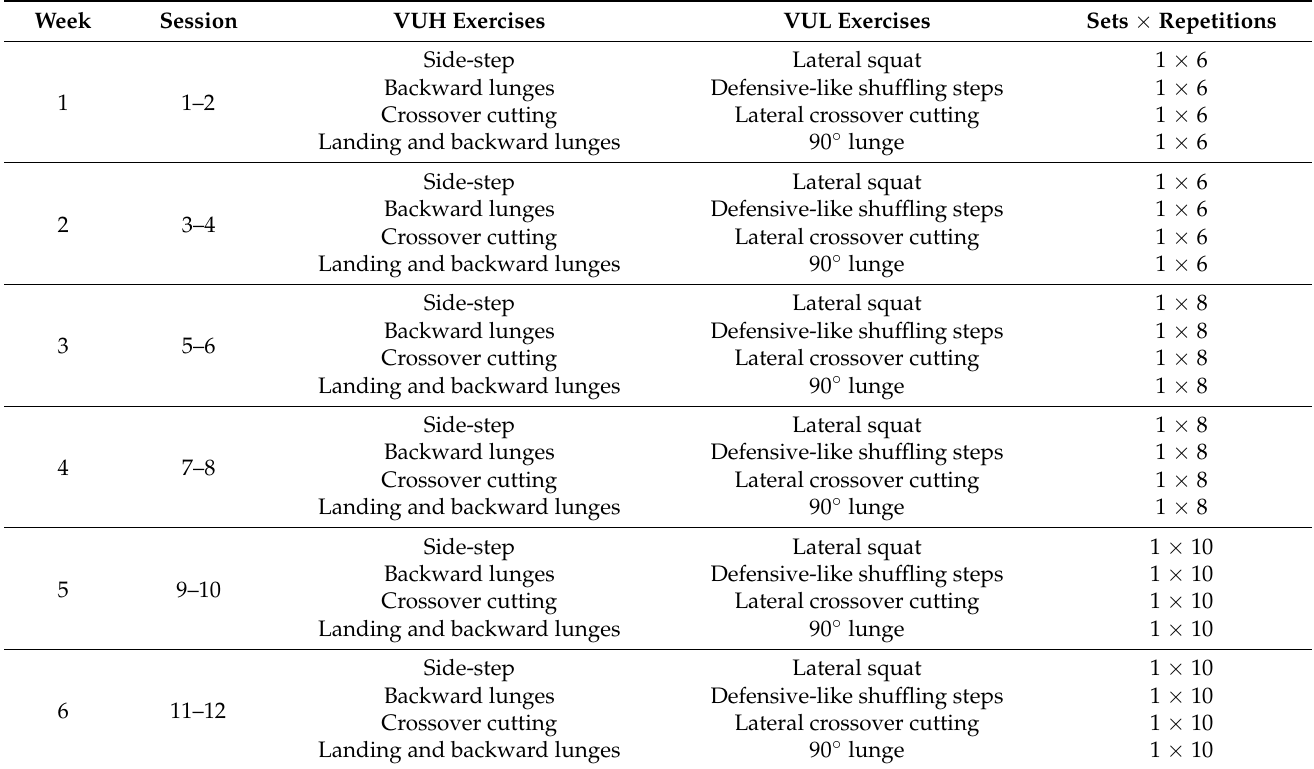
Table 1. Program training exercises and